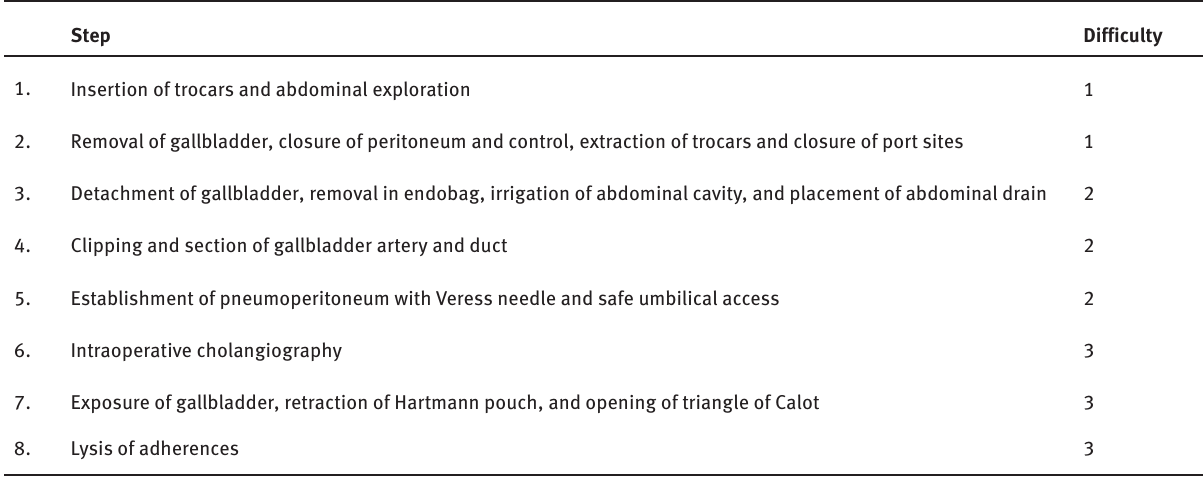
Table 2: Key steps in videolaparoscopic cholecystectomy according to degree of difficulty